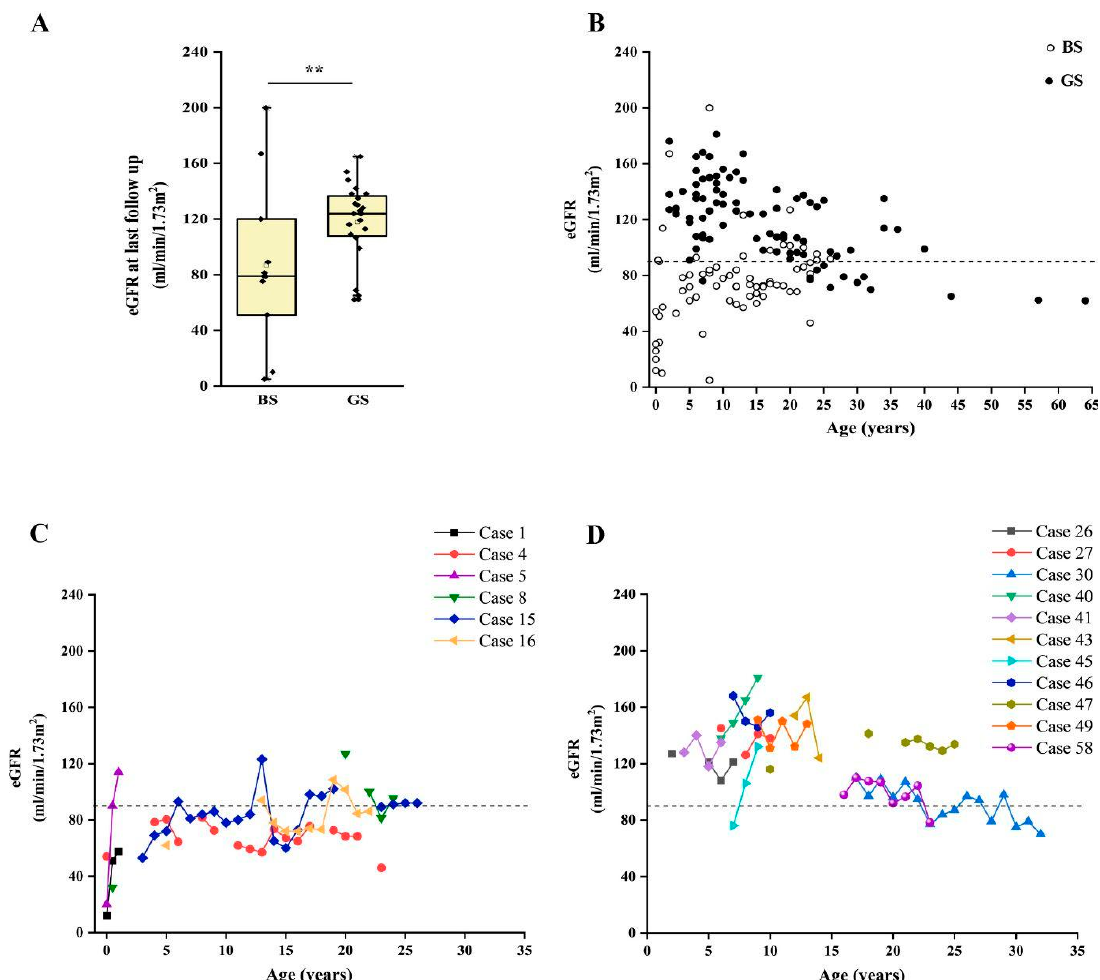
Figure 4. Long-term outcome of patients with BS and GS. ( A ) Box and whiskers plot of eGFR at last follow up in patients with a molecular diagnosis of BS and GS. Individual scores are shown as ▪ . ( B ). Plot of eGFR over time in patients with a molecular diagnosis of BS (white dots) and GS (black dots). Each dot represents a measurement in one patient. ( C ) Plot of the eGFR over time in patients with a molecular diagnosis of BS with at least three measurements during follow up. ( D ) Plot of the estimated glomerular filtration rate over time in a subset of patients with a molecular diagnosis of GS with at least three measurements during follow up. eGFR was calculated with Schwartz revised formula in children and CKD-EPI in adults. ** p value < 0.001 . GS, Gitelman syndrome; BS, Bartter syndrome; eGFR, estimated glomerular filtration rate.